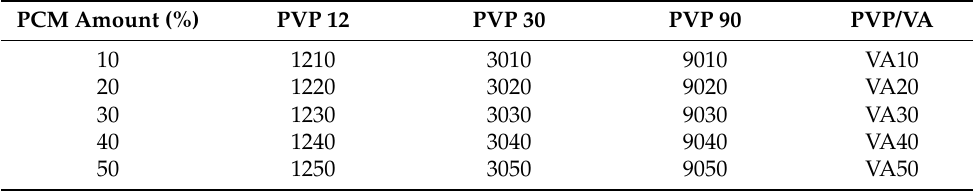
Table 1. Nomenclature of the different amorphous solid dispersion (ASD) powders. Example ASD powder 1230: The first two digits represent the polymer type (polyvinylpyrrolidone 12 (PVP 12), PVP/ vinyl acetate (PVP/VA)), and the last two digits represent the paracetamol (PCM) content (30%). The rest of the formulation consists of 70% polymer. PCM Amount (%) PVP